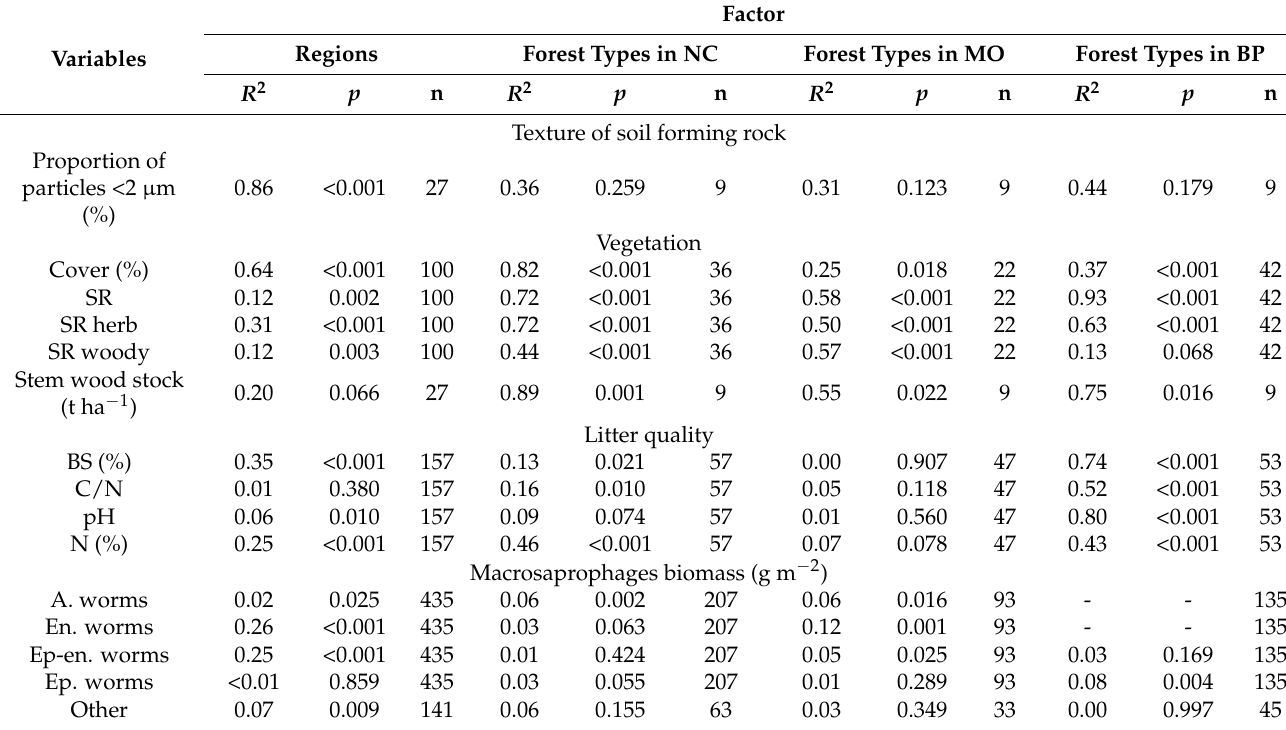
Table 1. One-way ANOVA of the region and forest type factors, affecting soil forming rock, vegetation, litter quality, and soil